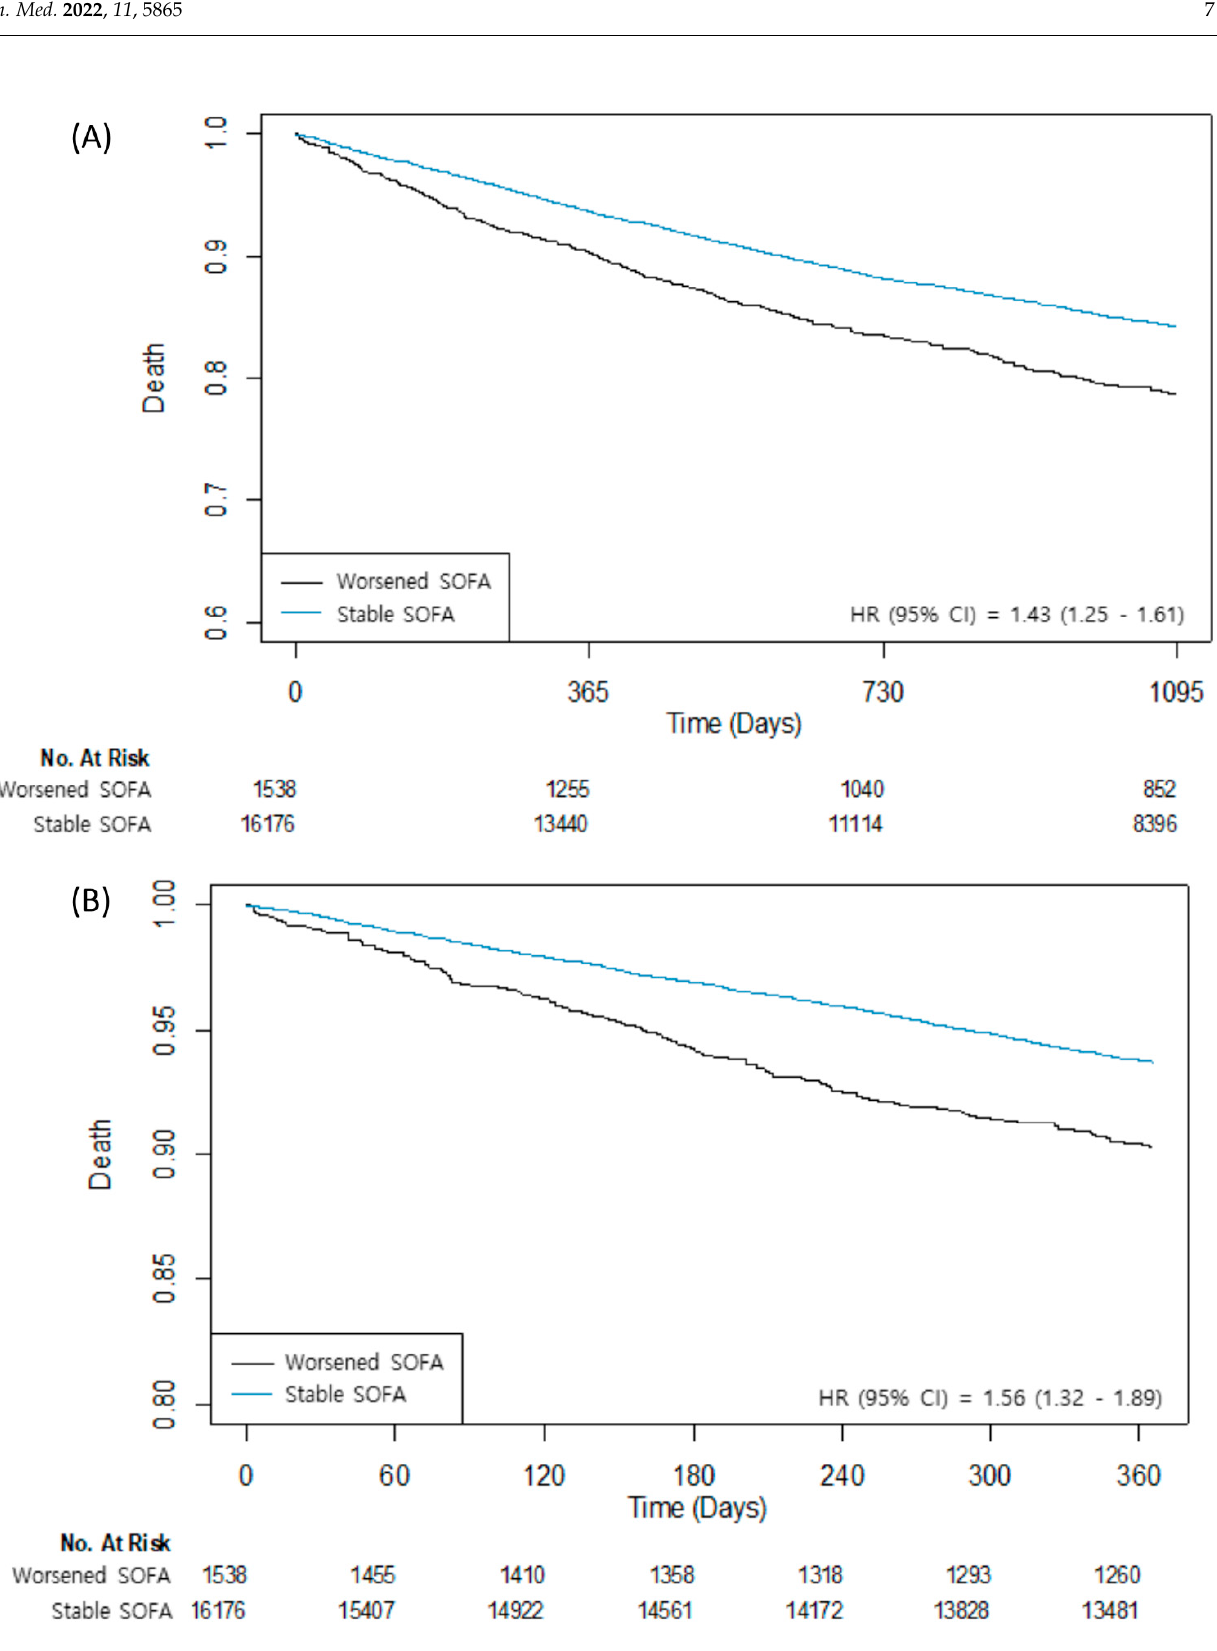
Figure 1. Kaplan–Meier curves for ( A ) three-year mortality and ( B ) one-year mortality.